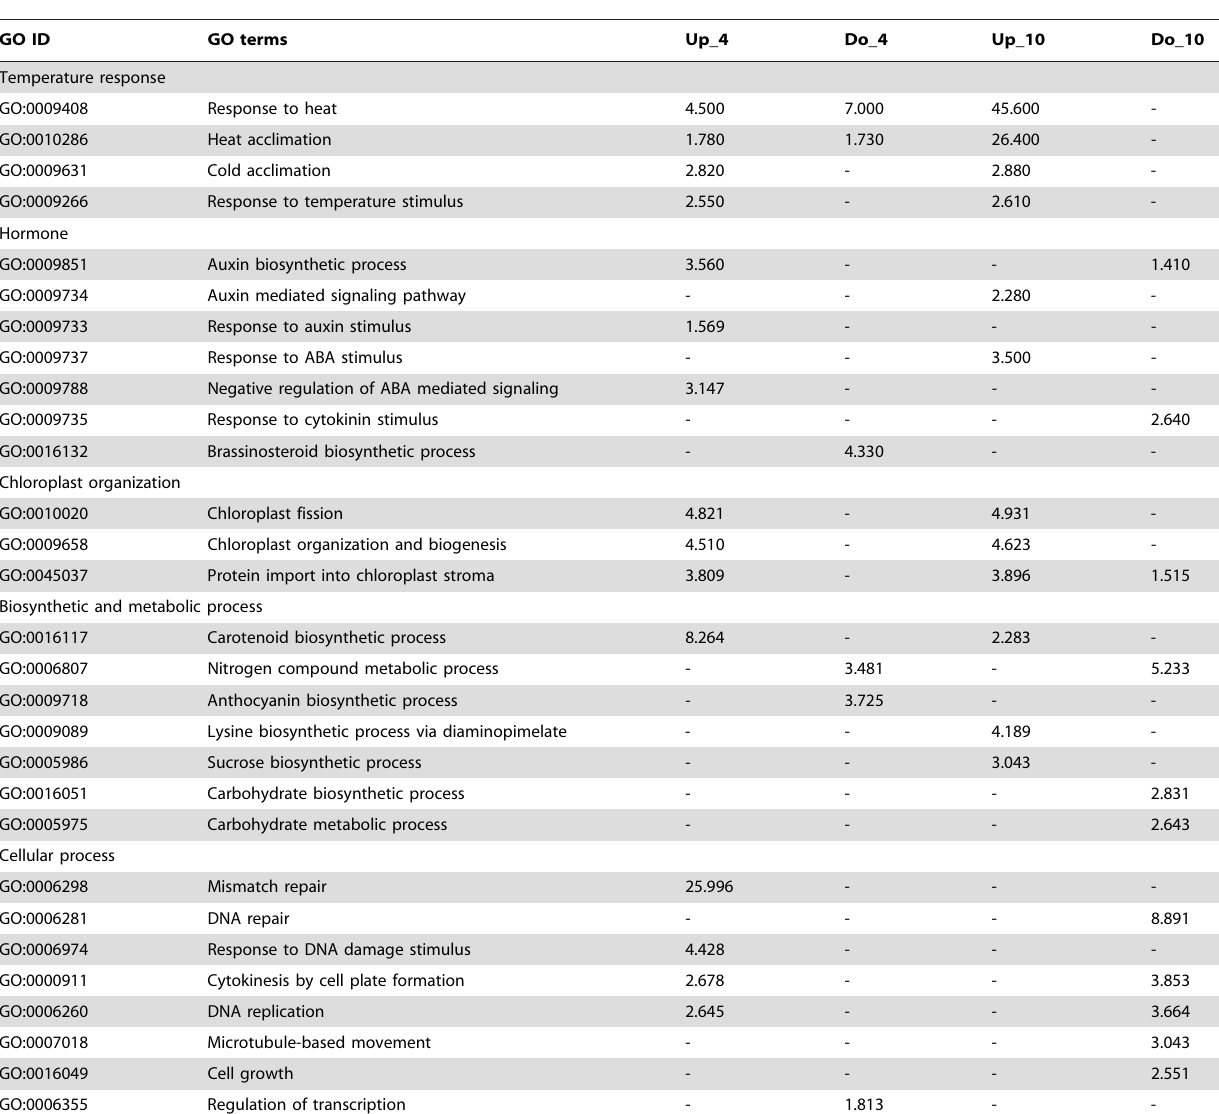
Table 2. Genes associated with different biological processes regulated by low temperature in Zhonghua 11.